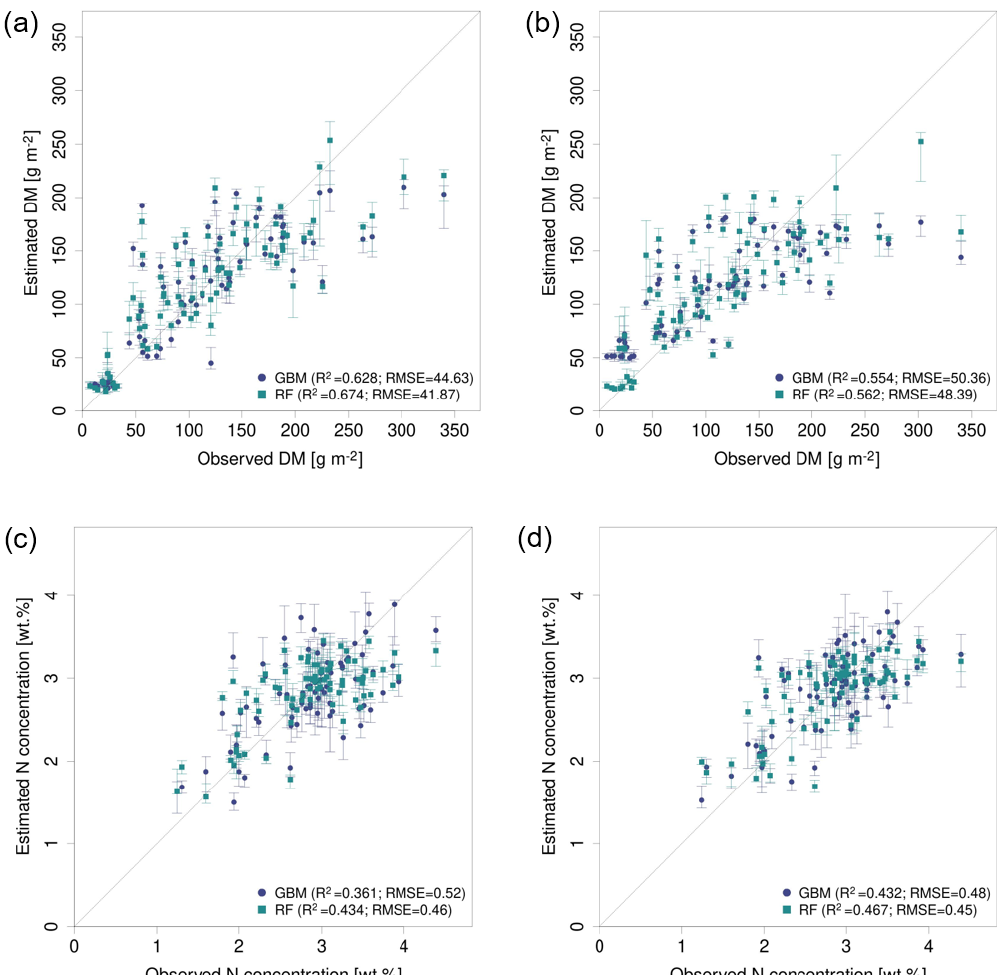
Figure 7. Observed vs. estimated parameter values for the best performing predictor set PS6 (raw reflectance data + VI + canopy height) comparing GBM and RF models (a) for DM with REM data, (b) for DM with SEQ data, (c) for N concentration with REM data, and (d) for N concentration with SEQ data. The error bars reflect 90% prediction intervals, defined by 5th and 95th percentiles of the 10 iterations.